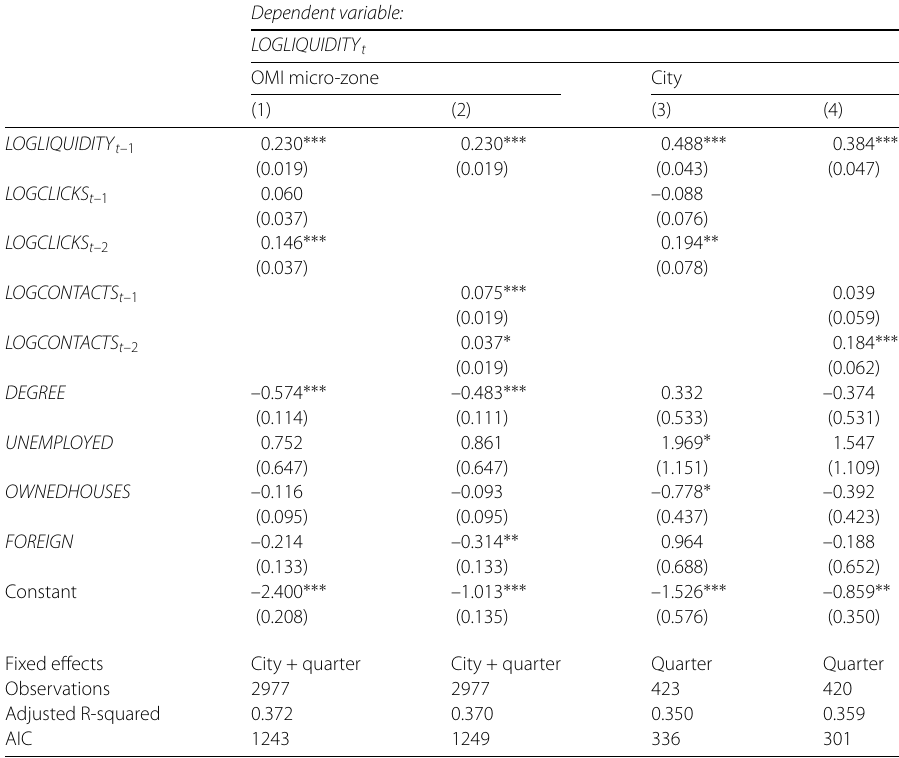
Table 3 Lagged effect of aggregate online interest on liquidity